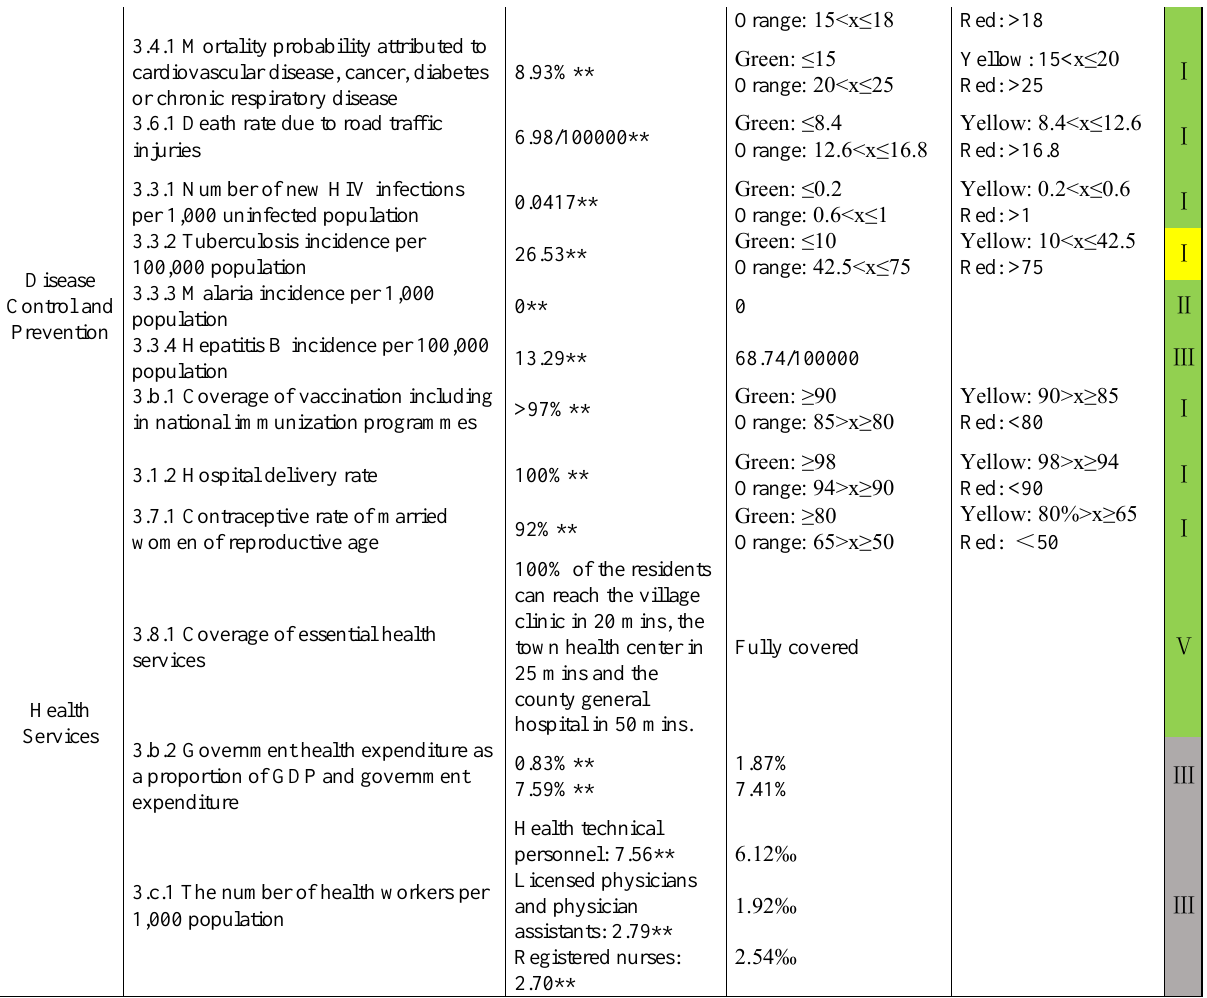
Table 2. Quantified indicators for SDG